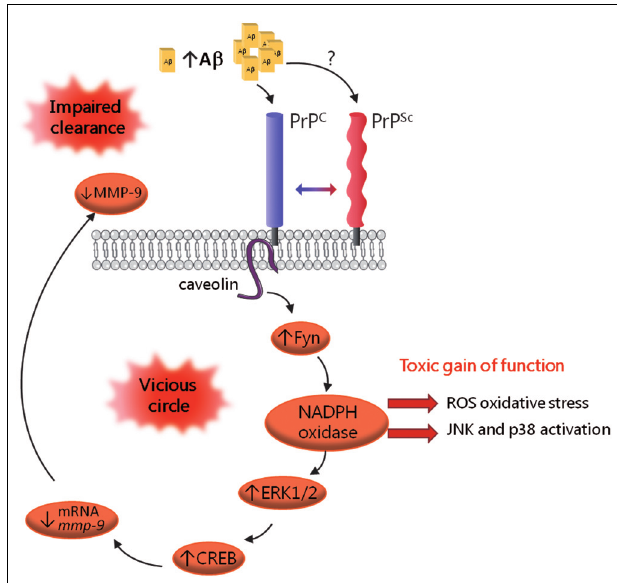
FIGURE 2 | Schematic representation of the corruption of PrP c -mediated signaling in prion-infected cells. PrP Sc accumulation is associated with the constitutive recruitment of various effectors of PrP c , including the Fyn kinase, the MAP kinases ERK1/2 and the CREB transcription factor. Prion-infected cells also exhibit recruitment of the stress-associated kinases p38 and JNK, which mirrors oxidative stress conditions. A downstream event in this cascade is the drastic reduction in MMP-9 mRNAs and activity, which, in turn, causes an impairment in A β clearance, leading to A β accumulation. A β oligomers would bind PrP c and possibly PrP Sc and further fuel the activation of this signaling cascade, thereby sustaining a vicious